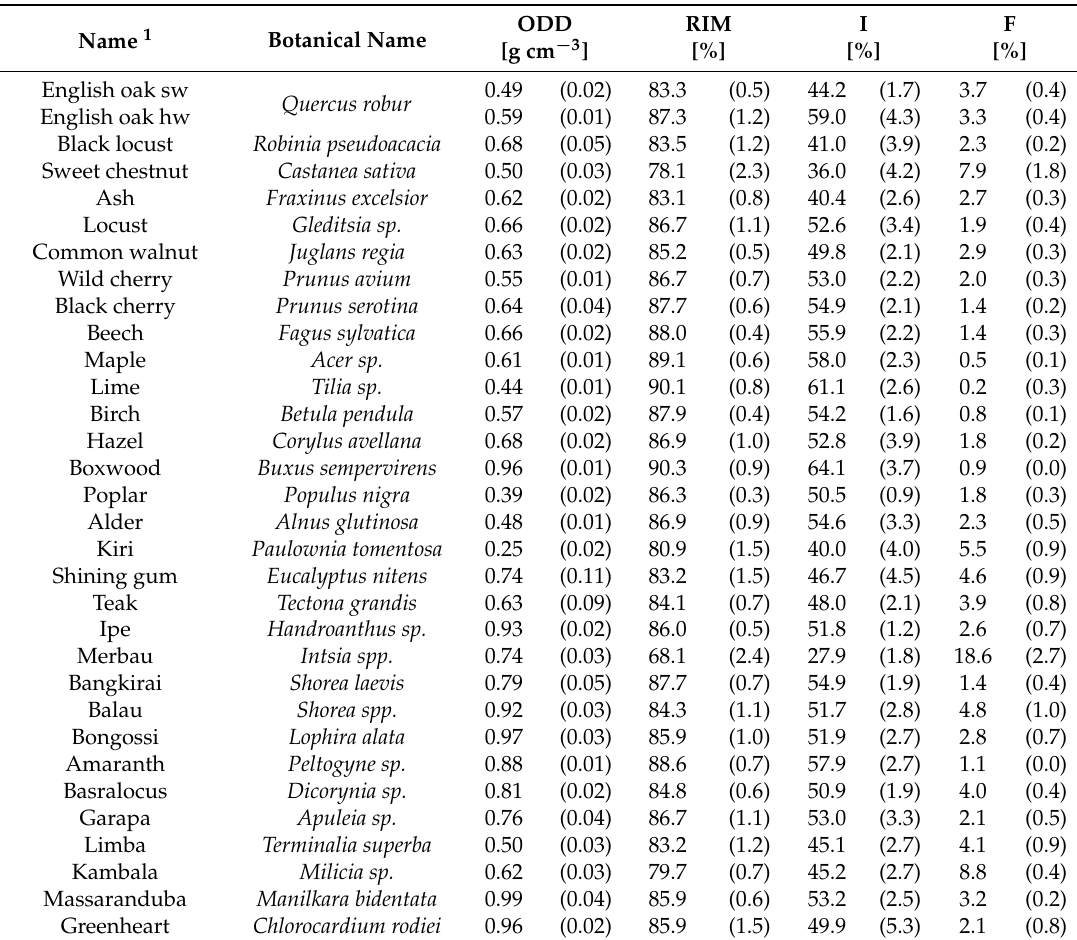
Table 2. The oven-dry density (ODD), Resistance to Impact Milling (RIM), degree of integrity (I), and fine percentage (F) of different hardwood species. The standard deviation (SD) is in